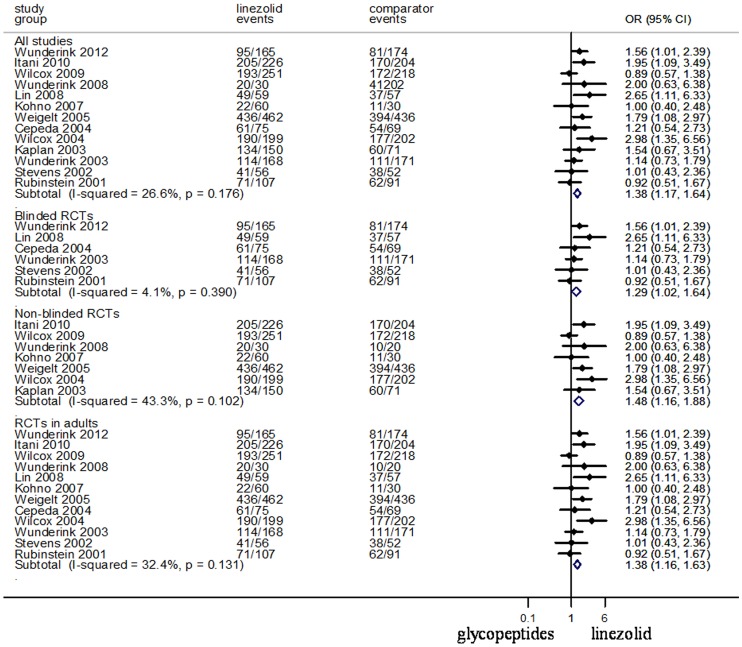
Meta-analyses of treatment success for clinically assessed patients.Test of all studies for overall effect: Z = 3.65 P = 0.000; test of blinded RCTs for overall effect: Z = 2.11 P = 0.035; test of Non-blinded RCTs for overall effect: Z = 3.03 P = 0.002; test of RCTs in adults for overall effect: Z = 3.64 P = 0.000.